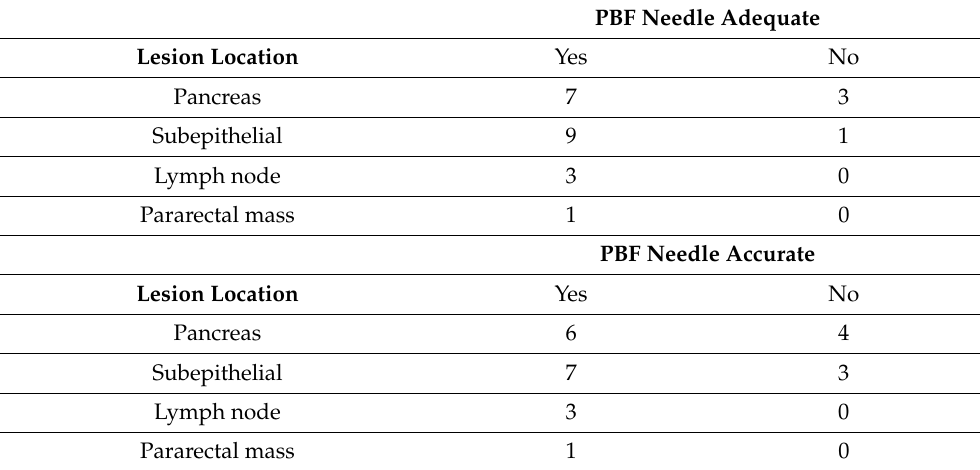
Comparison of sample adequacy and diagnostic accuracy of the PBF needle by lesion